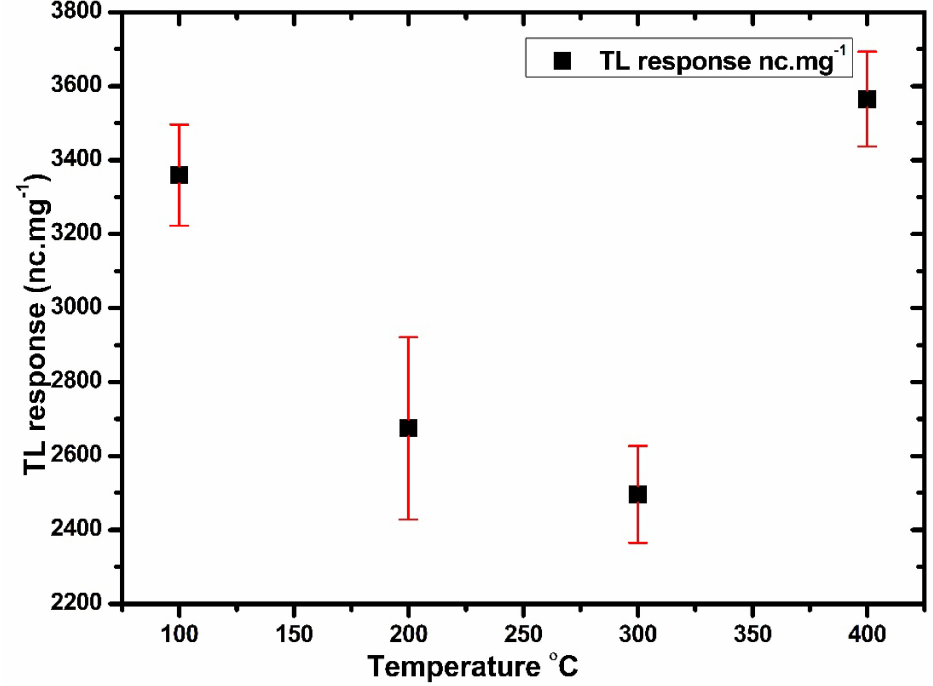
Figure 11. The TL response of Ag-doped ZnO thin films with different annealing temperatures.